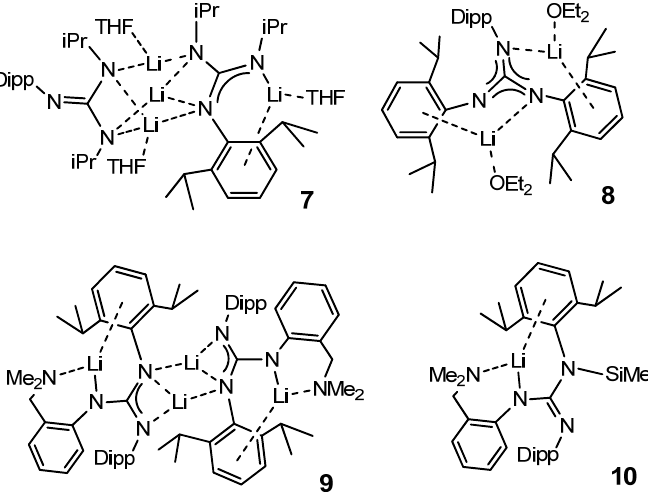
Figure 6. Alkali metal complexes exhibiting bond interactions with the aromatic substituents of the guanidinato ligands.